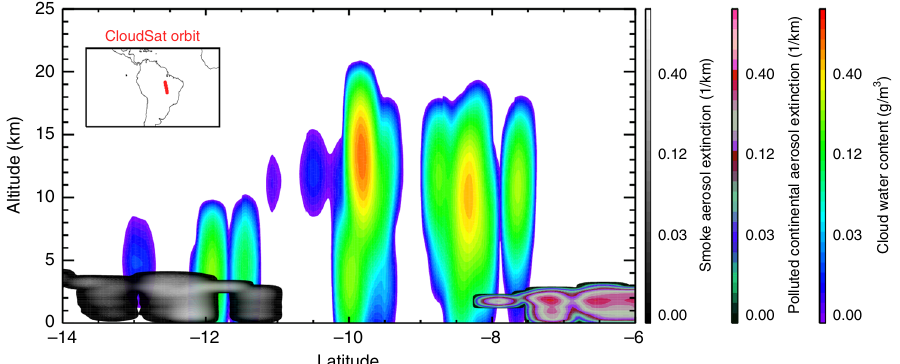
Fig. 1 Curtain plot of clouds in different aerosol environments. Curtain plot of CloudSat/CALIPSO cloud water content and collocated CALIPSO smoke and polluted continental aerosol extinction pro fi les along an orbit over South America on 25 October 2007. The image is smoothed by a 12 km running window along the satellite